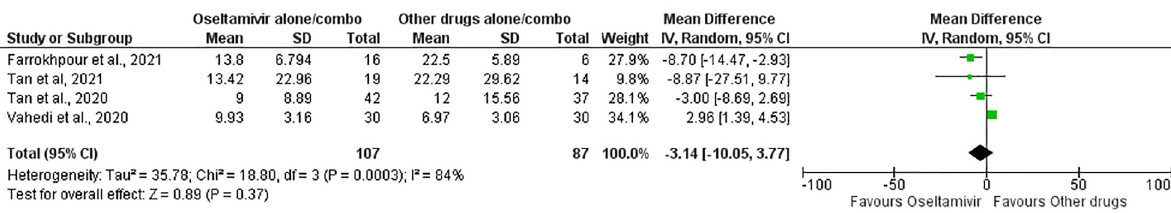
Fig 9. Forest plot. Shows the pooled effect estimate of the duration of hospitalisation of oseltamivir alone/combination compared with other drugs